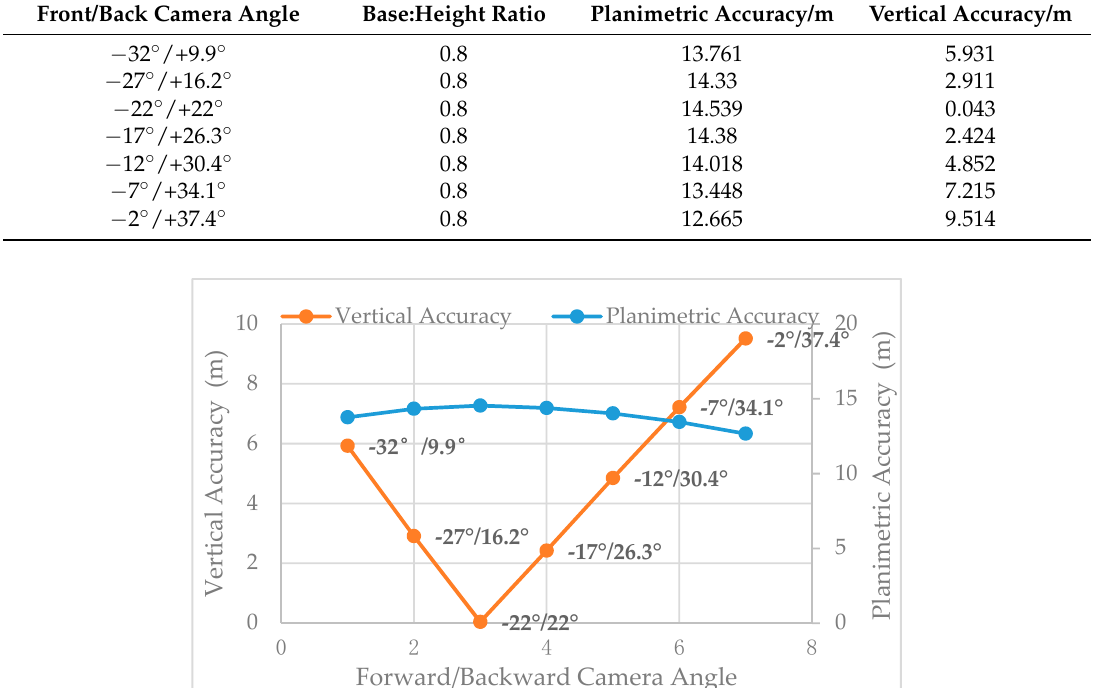
Table 5. Vertical accuracy statistics.